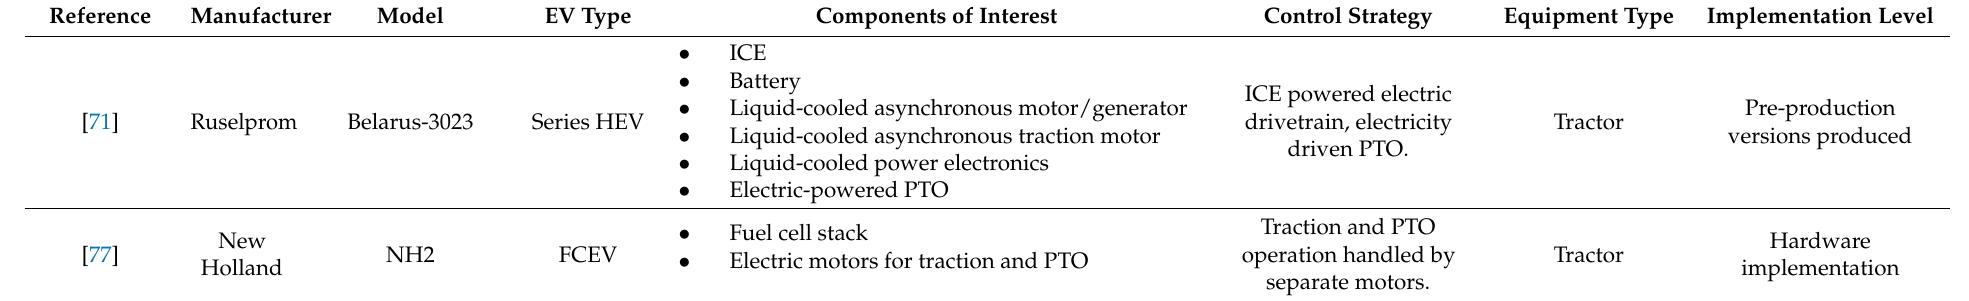
Table 6. Industrial research on electric off-road agricultural